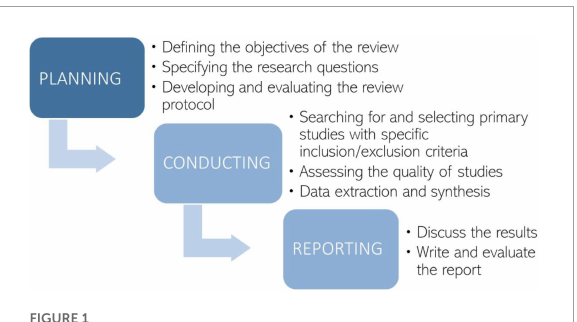
FIGURE1 Process of systematic literature review (adapted by Kitchenham and Charters,